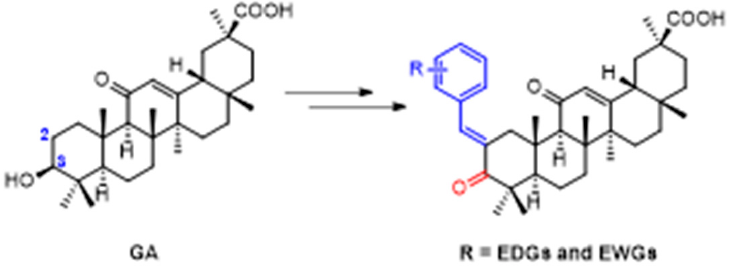
β -glycyrrhetinic acid